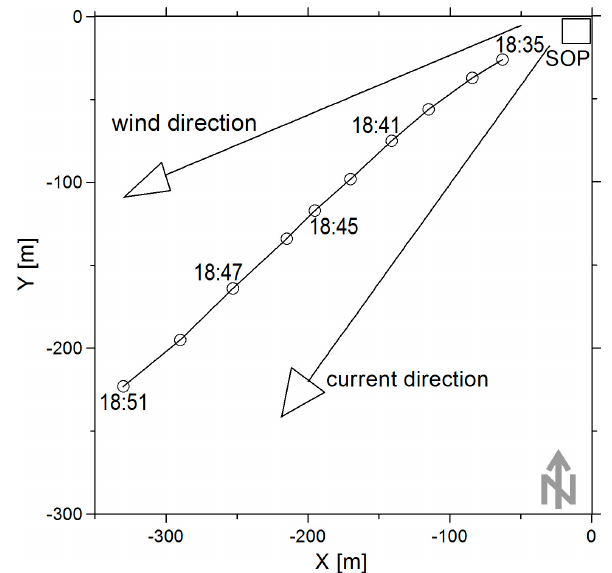
Figure 7. The trajectory of the downwind slick band edge. The rectangle schematically indicates the SOP, the circles indicate the downwind edge band structure position, the arrows show the average wind and current directions during the band formation. Distances along the axes North (Y) and East (X) of the SOP are given in meters.